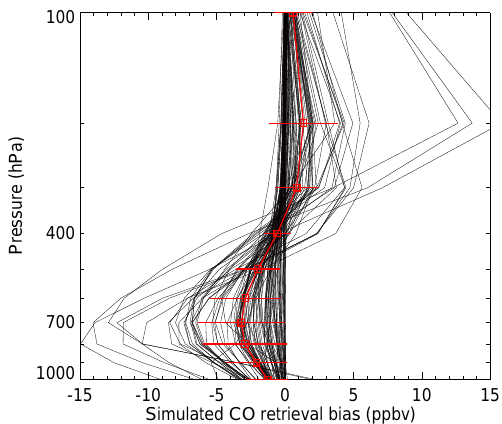
Figure 1. Simulated retrieval biases due to 3% increase in atmo- spheric N 2 O